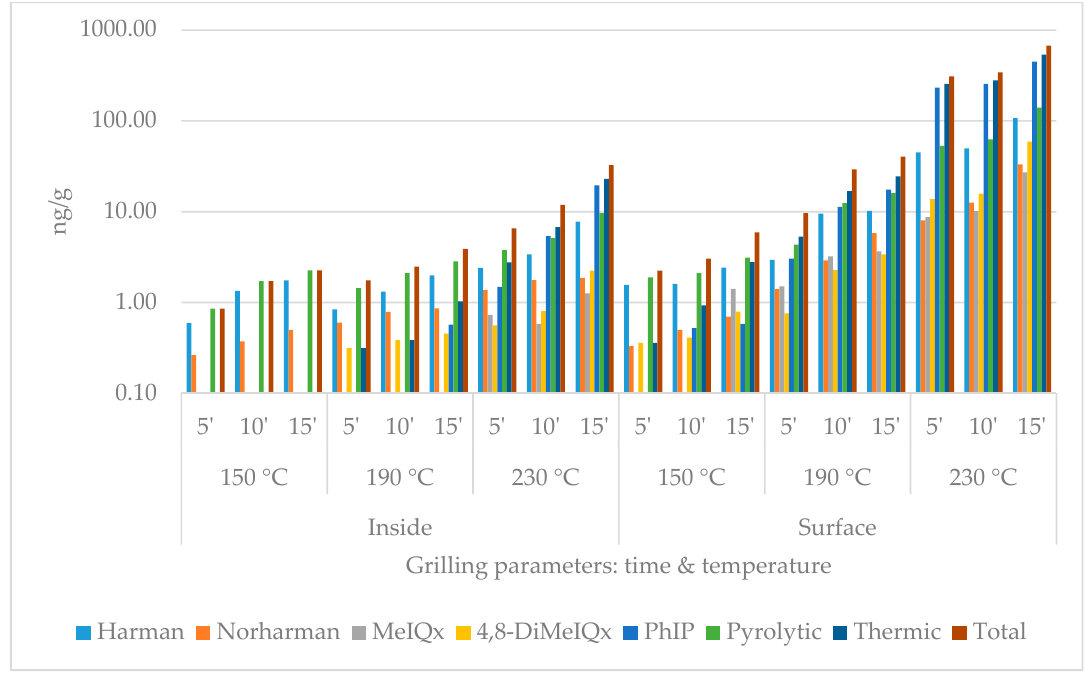
Figure 1. Heterocyclic amine content of chicken breast without skin grilled with closed top plate. (logarithmic scale).